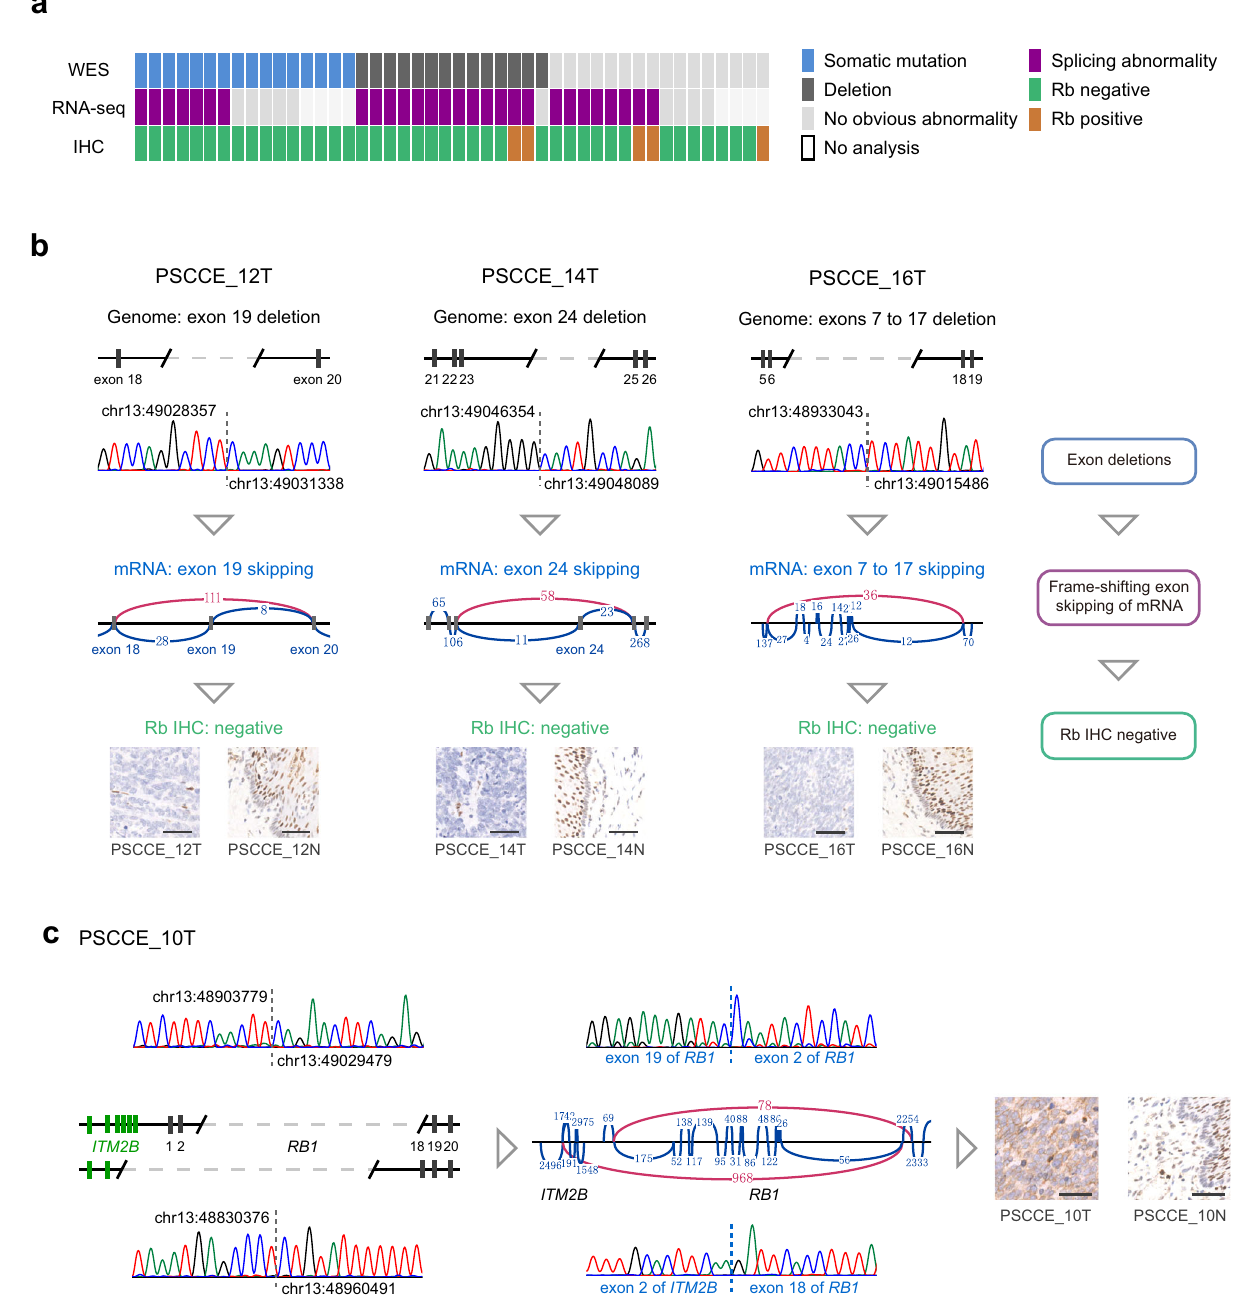
Fig. 2 RB1 disruption by multiple mechanisms. a Schematic summary of RB1 disruption events observed in each sample (column) by different methods (row). The rightmost sample is PSCCE_33T, the only tumor positive for Rb, yet not evaluated by RNA-seq. b (From top to bottom) Schematic plot of exon deletions, Sanger sequencing validation of exon deletion breakpoints, sashimi plot of subsequent splicing abnormalities in RB1 mRNA and Rb IHC of three representative tumors. Schematic summary of disrupting mechanism is shown on the right. Black rectangles represent RB1 exons and gray dashed line represent deleted genomic regions. Green, red, blue, and black peaks in Sanger sequencing chromatograms represent bases A, T, C, and G, respectively. Genomic coordinates are in hg19 assembly. Curves in sashimi plot represent reads spanning exon junction with numbers of reads denoted. Abnormal exon junctions are plotted in red. Rb IHC of matched normal sample is provided as control. Scale bar: 50 μ m. c Schematic plot and Sanger sequencing validation of exon deletions (left), sashimi plot and validation of abnormal mRNA exon junctions (middle) and Rb IHC staining (right) of PSCCE_10T. Two alleles of RB1 are plotted separately to show different ranges of exon deletions. Exons of ITM2B are plotted in green. Sanger sequencing chromatograms and sashimi plots are plotted in the same way described above. Scale bar: 50 μ